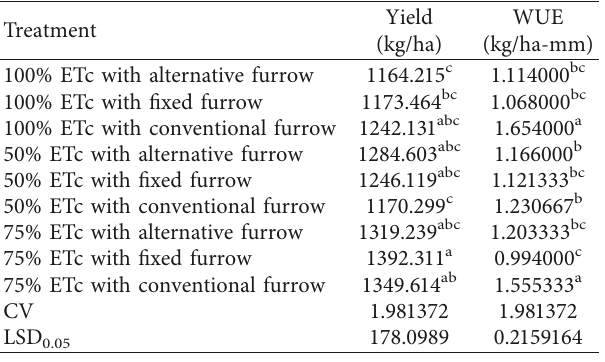
Table 6: Combined sesame yield and WUE response over years during the cool cropping season.